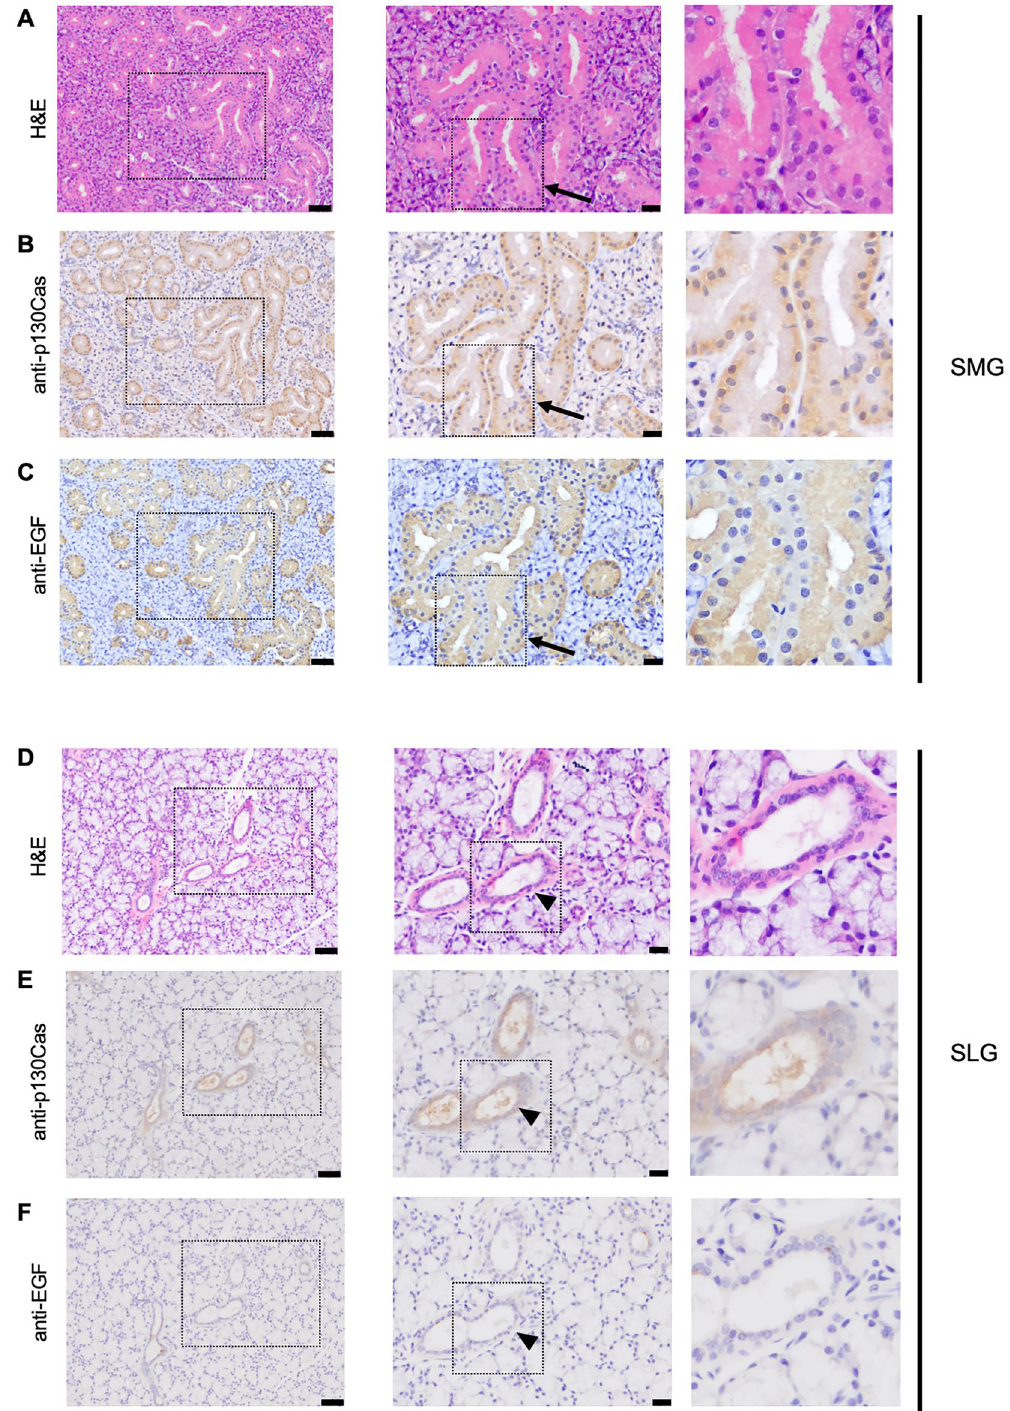
Figure 1. The expression and localization of p130Cas in the salivary gland. Histological analysis of submandibular glands (SMG) ( A – C ) and sublingual gland (SLG) ( D – F ) from P42 male wild-type mice. Represented images for H&E staining ( A , D ), and immunohistochemical staining of SMG and SLG using an anti-p130Cas antibody ( B , E ) or anti-EGF antibody ( C , F ). Black boxed regions are shown as magnified images. Scale bars = 50 µm (left panel) and 20 µm (middle panel). Arrows indicate the GCT in SMG. Arrowheads indicate ducts in